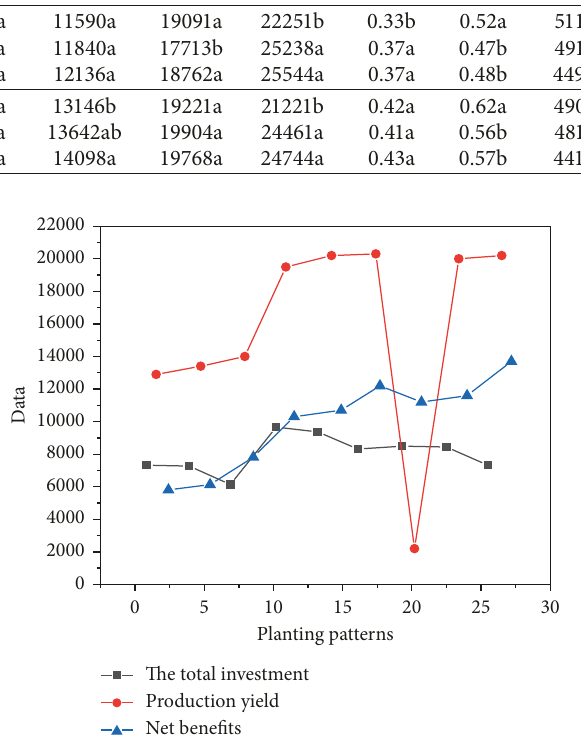
Figure 2: Effects of stubble retention and planting mode on crop economic